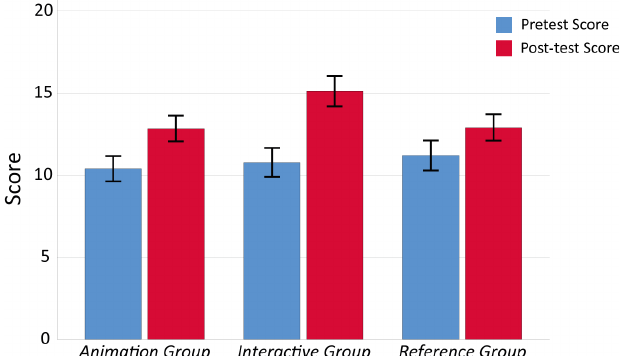
FIG. 7. Average scores of the pretest and the post-test for the three training groups. The error bars represent the standard error of the